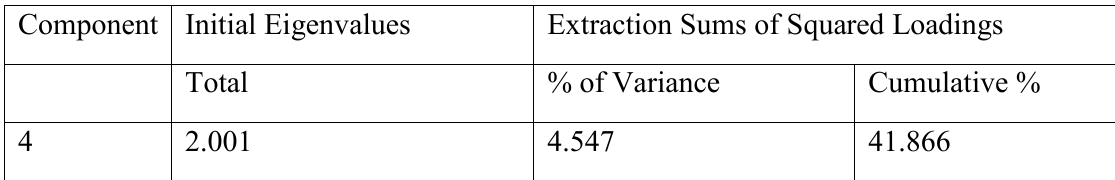
Table 1.7: Variance explained for Absorptive Resilience PC4ariance explained for Absorptive Resilience PC4